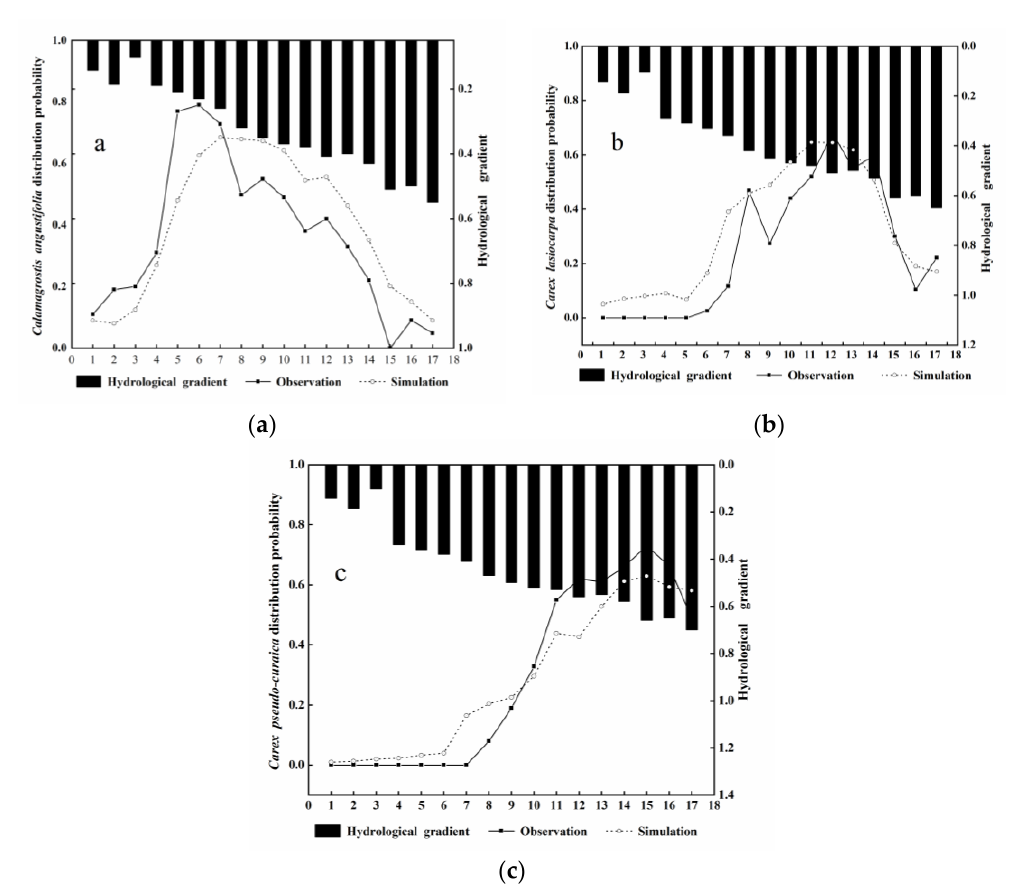
Figure 8. Comparison of observed and simulated vegetation probability of occurrence in transect 2: ( a ): Calamagrostis angustifolia ; ( b ): Carex lasiocarpa ; ( c ): Carexpseudocuraica .